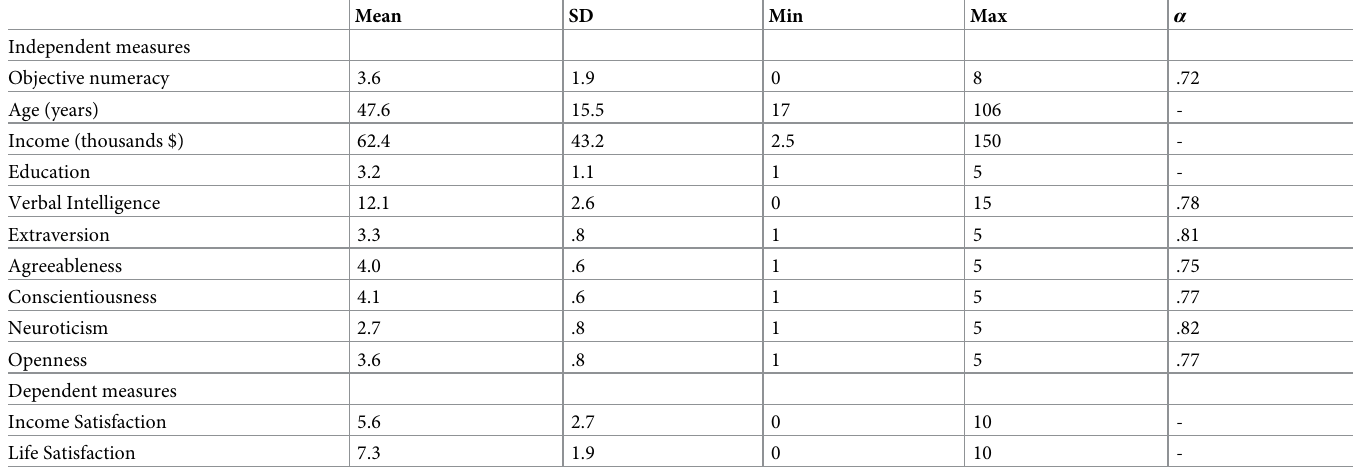
Table 1. Means, standard deviations, and ranges for continuous measures and Cronbach’s alpha for multi-item indexes.